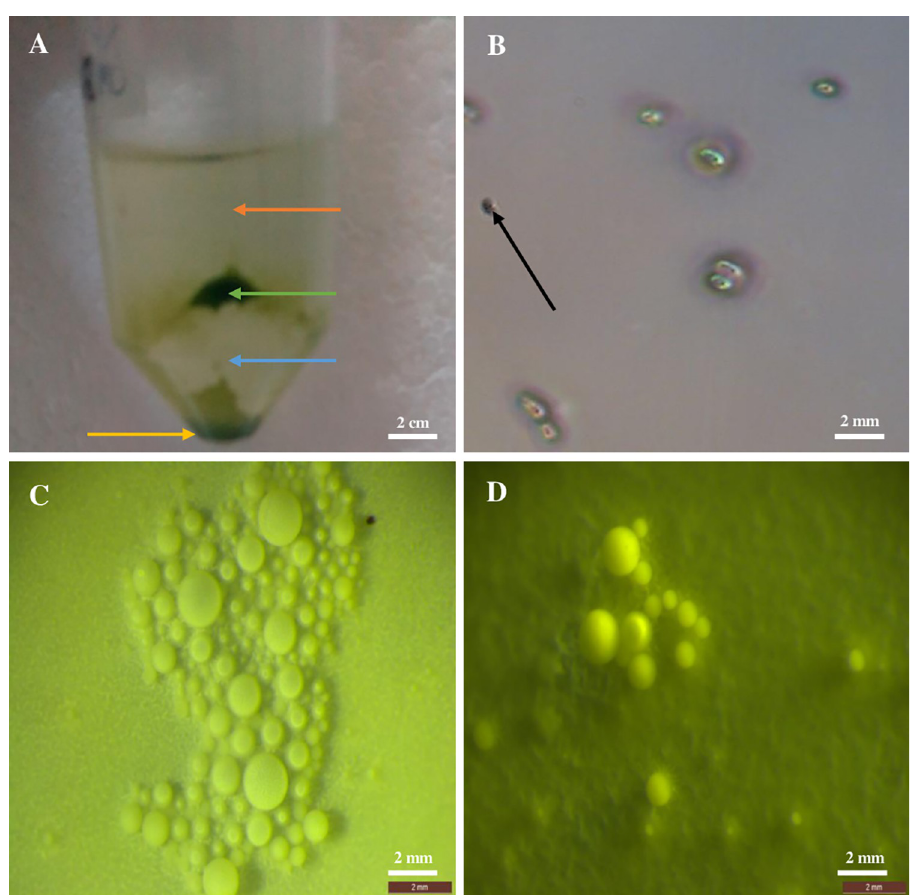
Fig 2. Protoplast solid media culture: A. Protoplast gradient centrifugation. Yellow arrow indicates the dead protoplast cells, blue arrow indicates the sucrose solution, green arrow indicate a cushion of living protoplast cells and orange arrow indicates the washing medium. B. Protoplast cells under × 100 after Evans-blue staining. Black arrows indicate non-viable cells. C. Protoplast growing on solid medium. D. Cell clumps/colonies on solid medium.